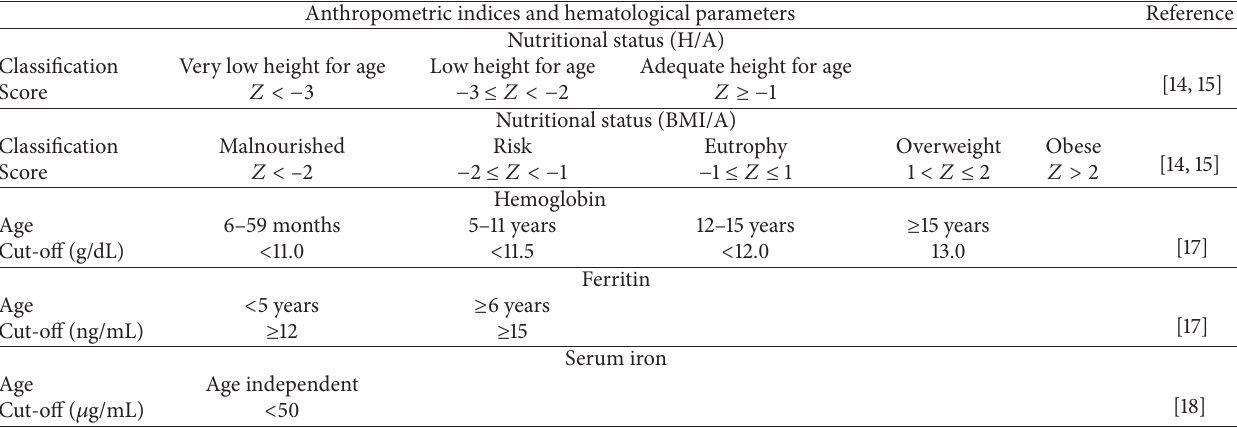
Table 2: Cut-off point criteria for nutritional status and hematological parameters according to age, for the evaluation of a sample of people aged 0 to 15 years in Macei´o, Alagoas,